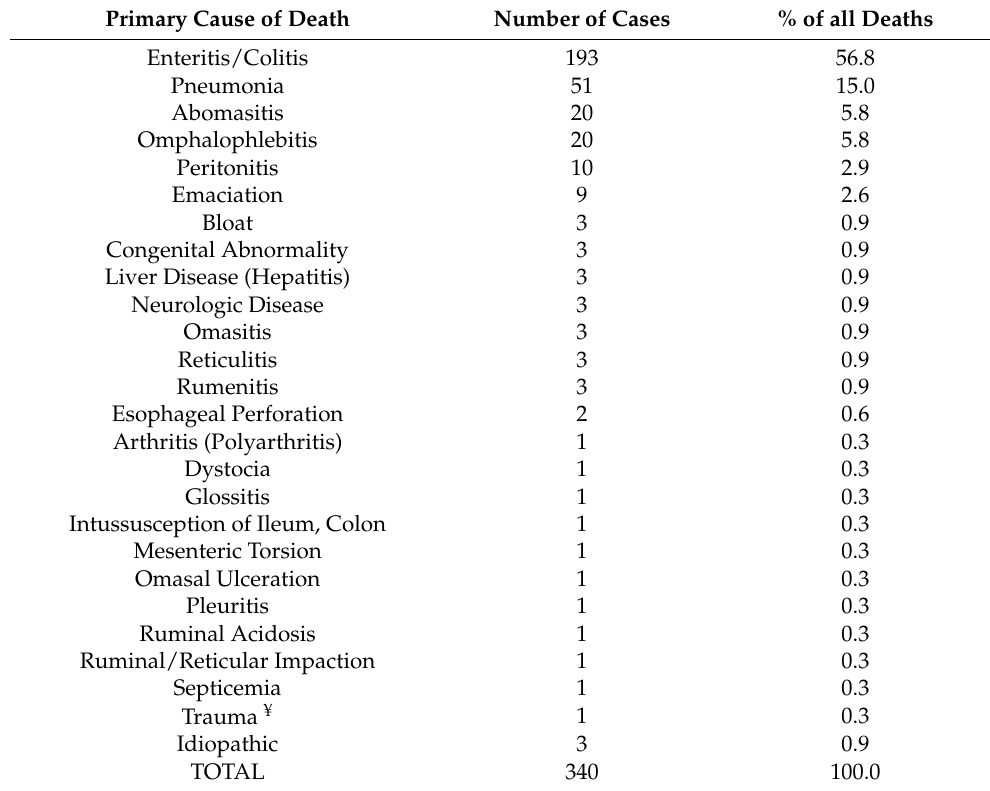
Table 4. Primary cause of death of 340 post-neonatal to approximate weaning age (6 days to 55 days old) calves diagnosed at necropsy.